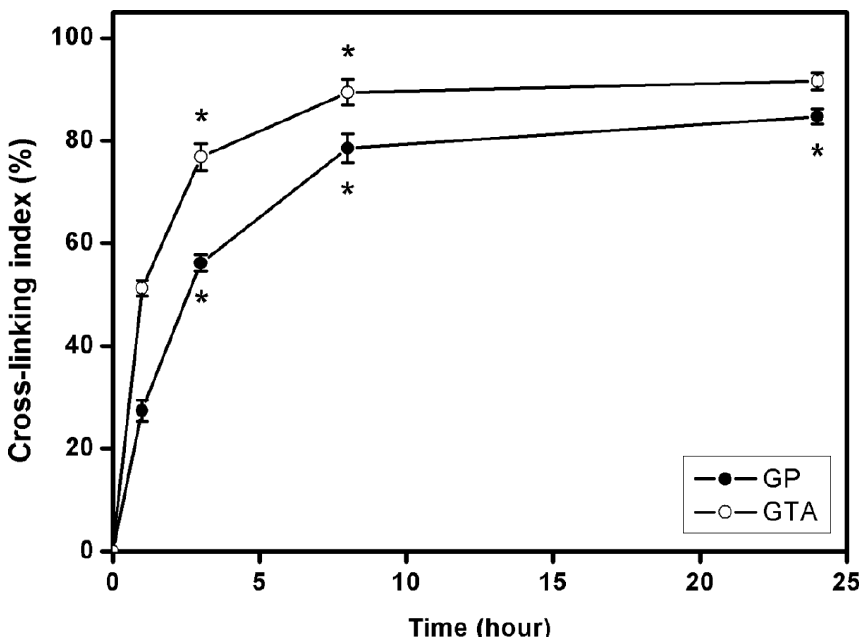
Figure 2. Cross-linking index of GP and GTA treated chitosan membranes as a function of cross-linking time. An asterisk indicates statistically significant differences (* p < 0.05; n = 5) for the mean value of cross-linking index compared with the value at the previous time point.